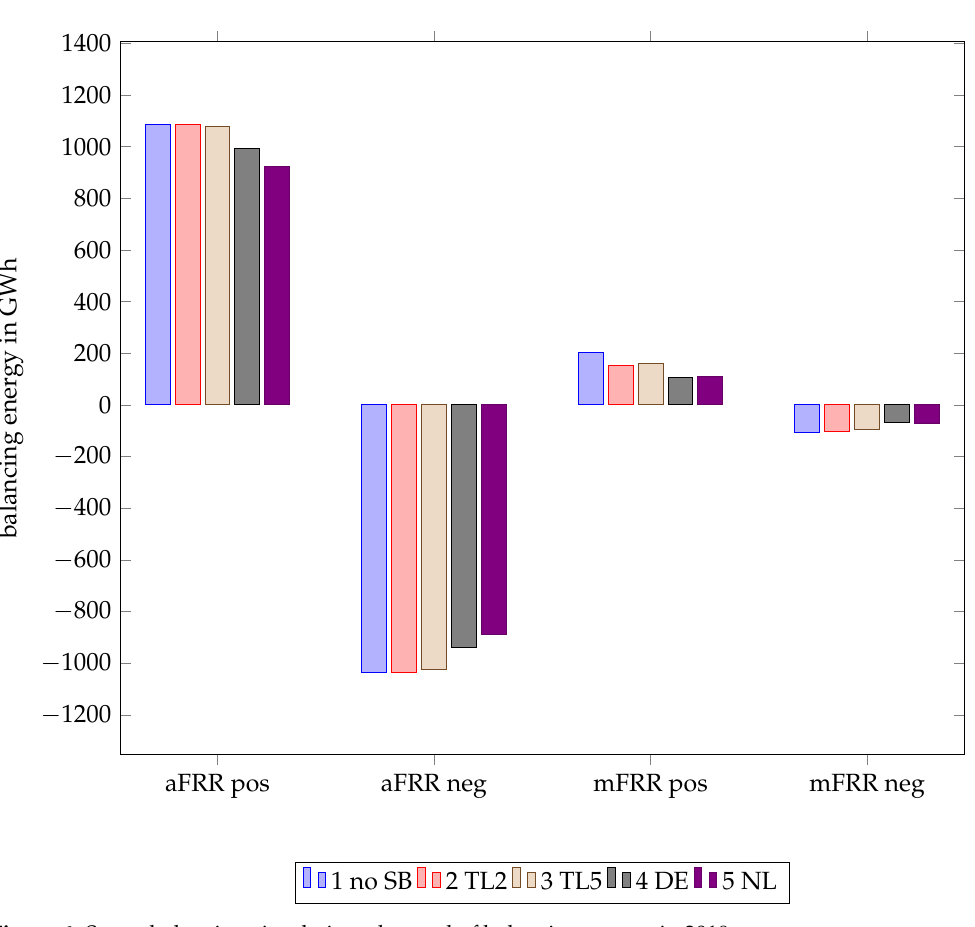
Figure 6. Smart balancing simulation: demand of balancing energy in